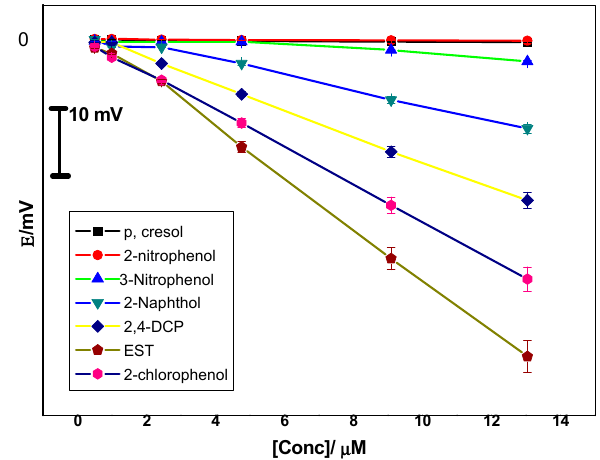
Figure 6. Potentiometric selectivity of MIP membrane-based sensors towards 17 β -estradiol (EST).